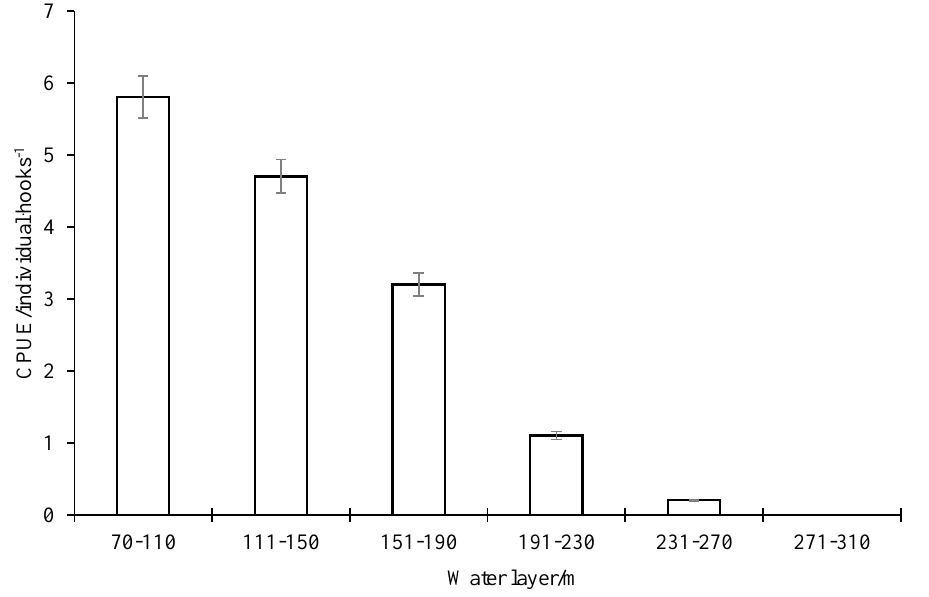
Figure 8. Number of catch per 1000 hooks (CPUE) 1j of Acanthocybium solandri in different water layer ranges.